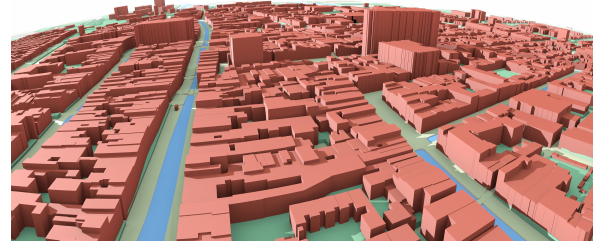
Figure 3: A simple 3D city model created by extruding buildings.